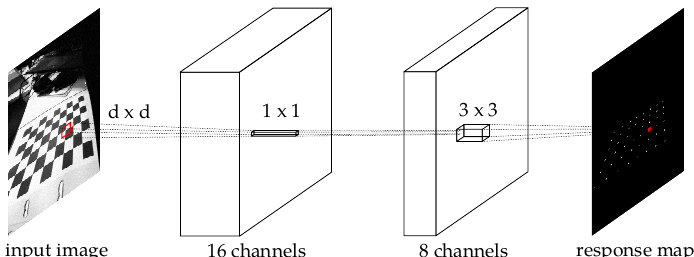
8 channels Figure 3. Overview of the proposed machine layers. The input image is first filtered with a relatively large kernel size (proportional to image content) into 16 feature channels. A direct filtering (no spatial influences) into eight new channels. The last step achieves a single-channel response map. The activation functions at each step are ReLUs (rectified linear units